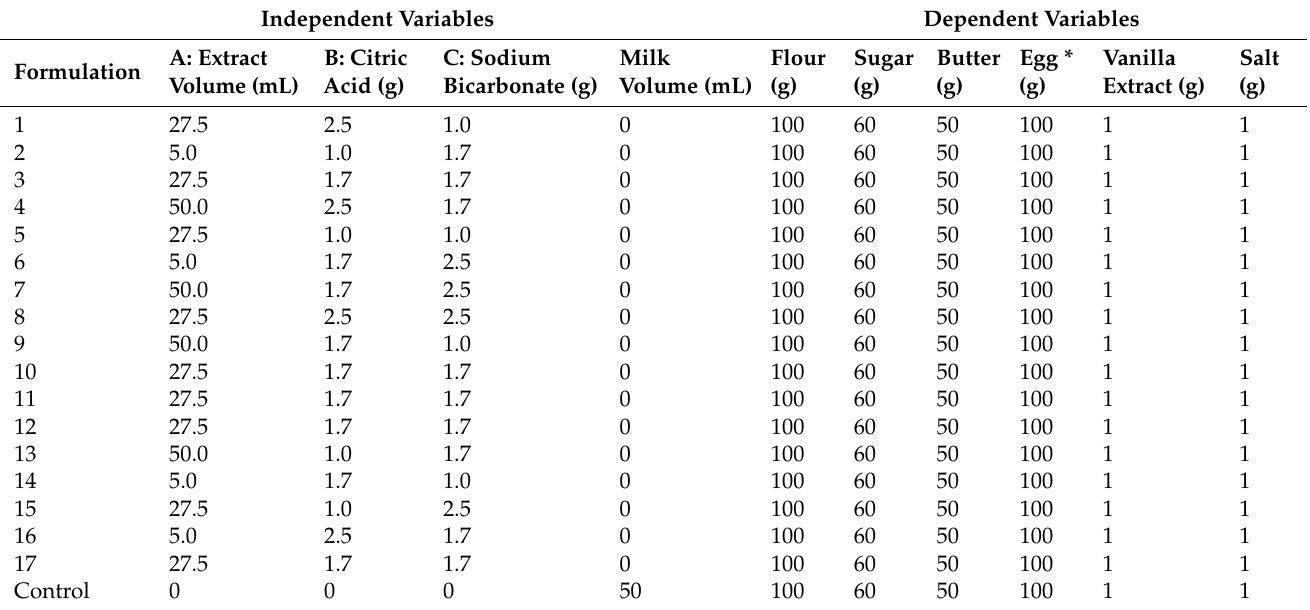
Table 9. Experimental design for preparation of Roselle muffins based on RSM along with